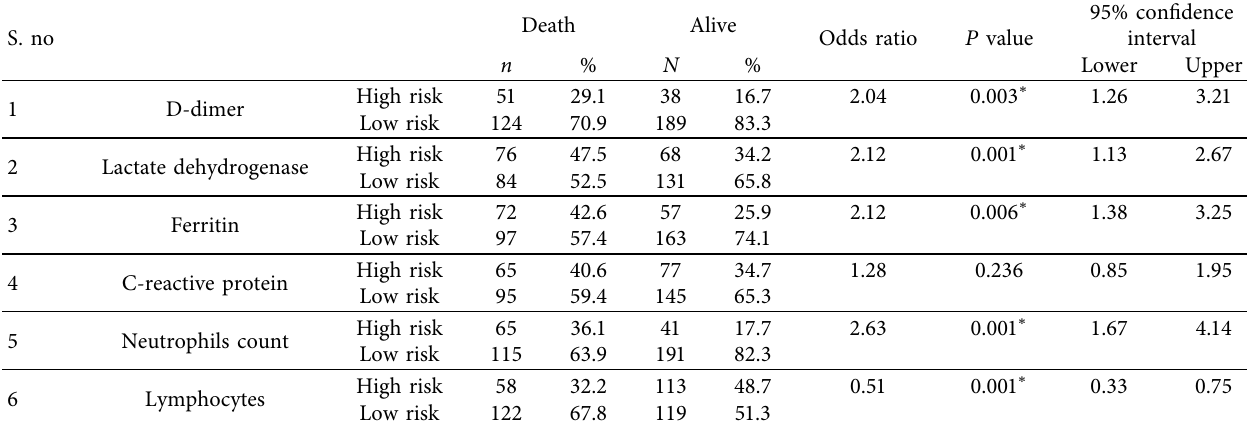
Table 3: Comparison of infammatory markers between survivors and non survivors by cross sectional univariate analysis. S. no